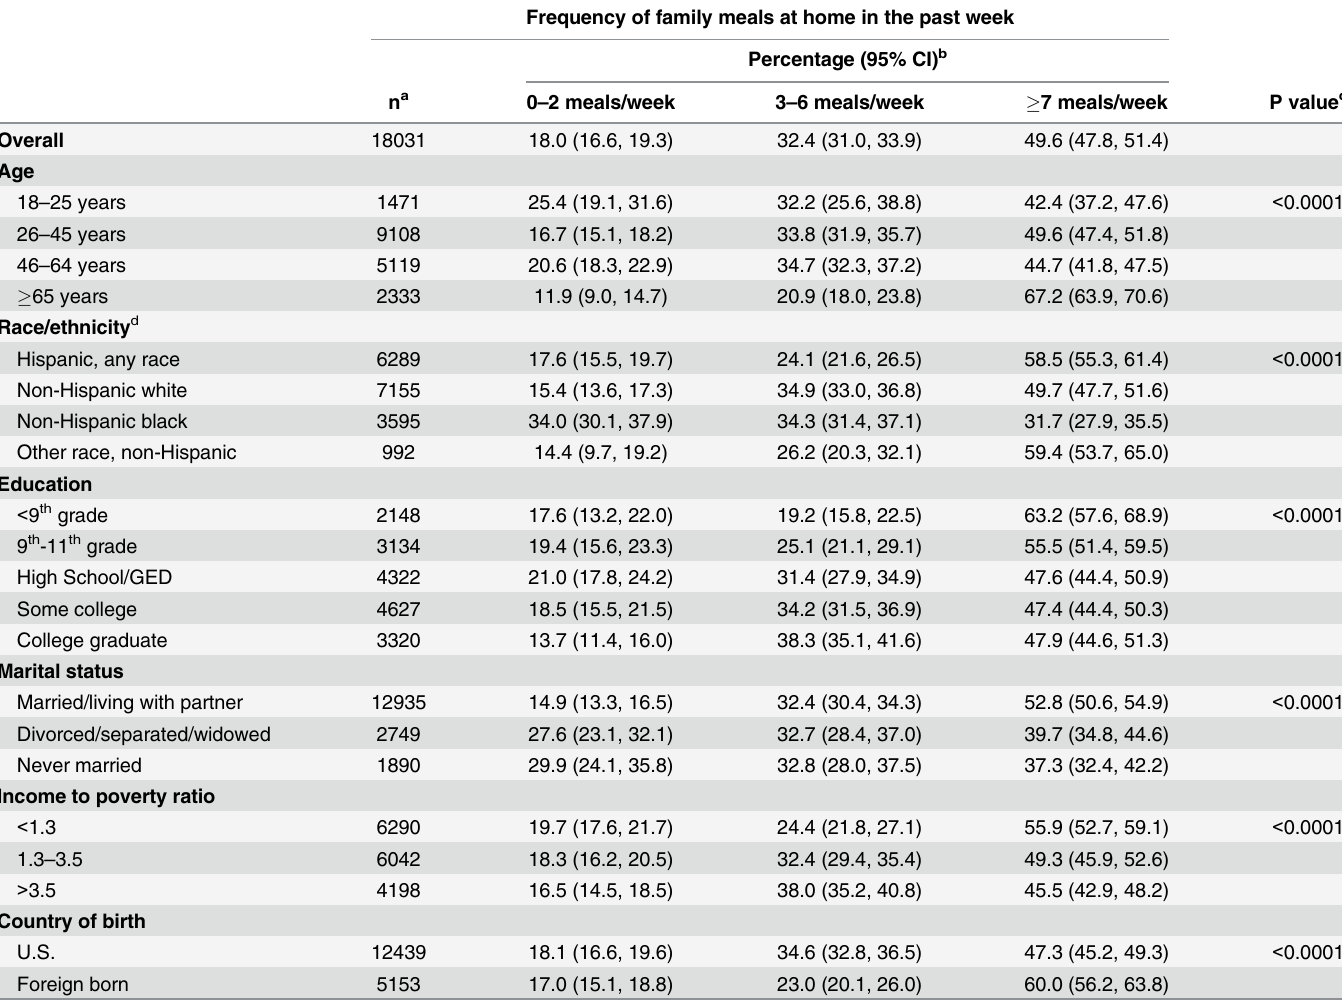
Table 1. Family meal frequency in U.S. multi-person households by sociodemographic characteristics of the householder. Frequency of family meals at home in the past